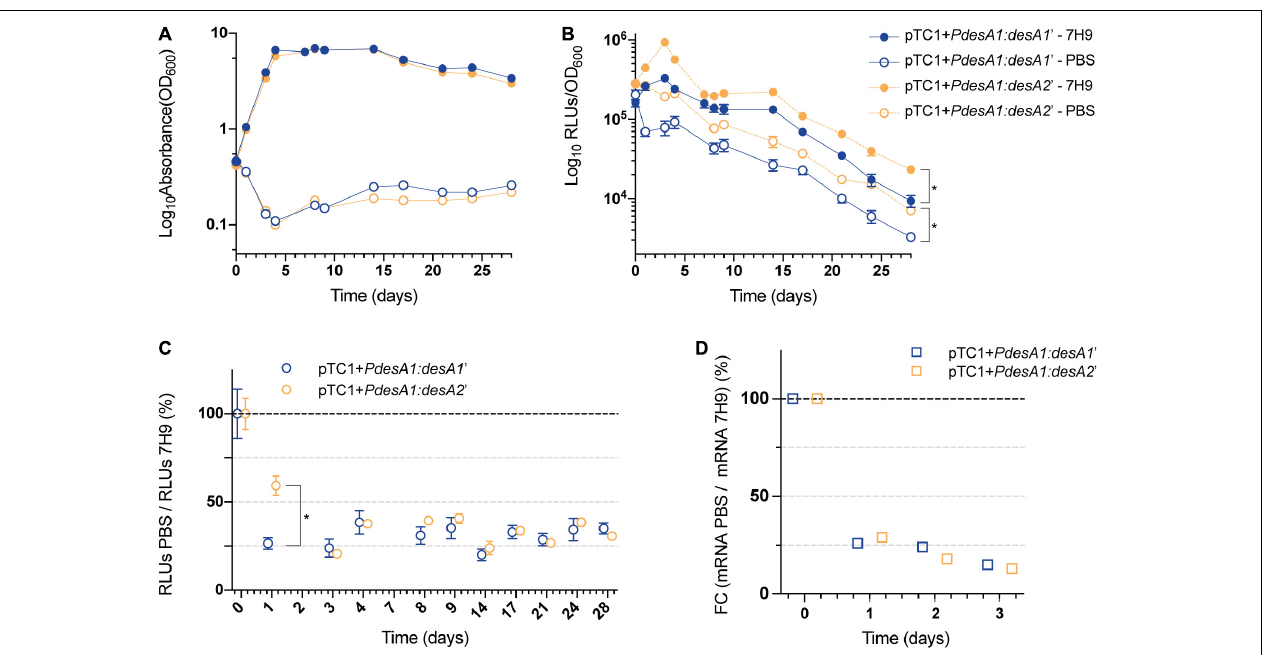
FIGURE 3 | Growth and translation kinetics of the leaderless and Shine–Dalgarno reporters during nutrient starvation. Cultures of M. tuberculosis carrying integrative vectors pTC1 + PdesA1 : desA1’ [Shine–Dalgarno (SD), blue] and pTC1 + PdesA1 : desA2 ’ [leaderless (L), orange] were grown to mid-exponential phase (time 0), washed and resuspended in PBS or kept in rich media as controls (7H9). For each timepoint and reporter at least three independent transformants were used and measurements were done in triplicate; the mean value and standard deviation are presented. (A) OD 600 was monitored for 28 days. (B) Luminescence, given as relative light units (RLUs) corrected by growth. Asterisks denote statistically significant differences between Shine–Dalgarno and leaderless reporters for all timepoints in each condition (7H9 and PBS) (multiple t -tests, p < 0.001). (C) To calculate the overall effect that nutrient starvation has on the translation of the reporters, for each timepoint and reporter, the RLU value during nutrient starvation (PBS) was normalized against the RLU control value (7H9). The value obtained at time 0 was considered as the 100% translation efficiency. Statistically significant differences are indicated with an asterisk (multiple t -tests, p < 0.001). (D) Quantification of mRNA levels by real-time PCR. 16S rRNA was used as the internal control. Fold changes (FC) are relative to mRNA levels in control cultures (7H9) and the value obtained at time 0 was considered as 100% transcription